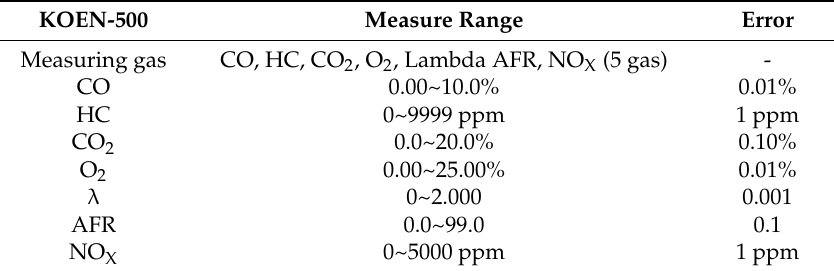
Table 6. Specifications of KOEN gas analyzer [44].